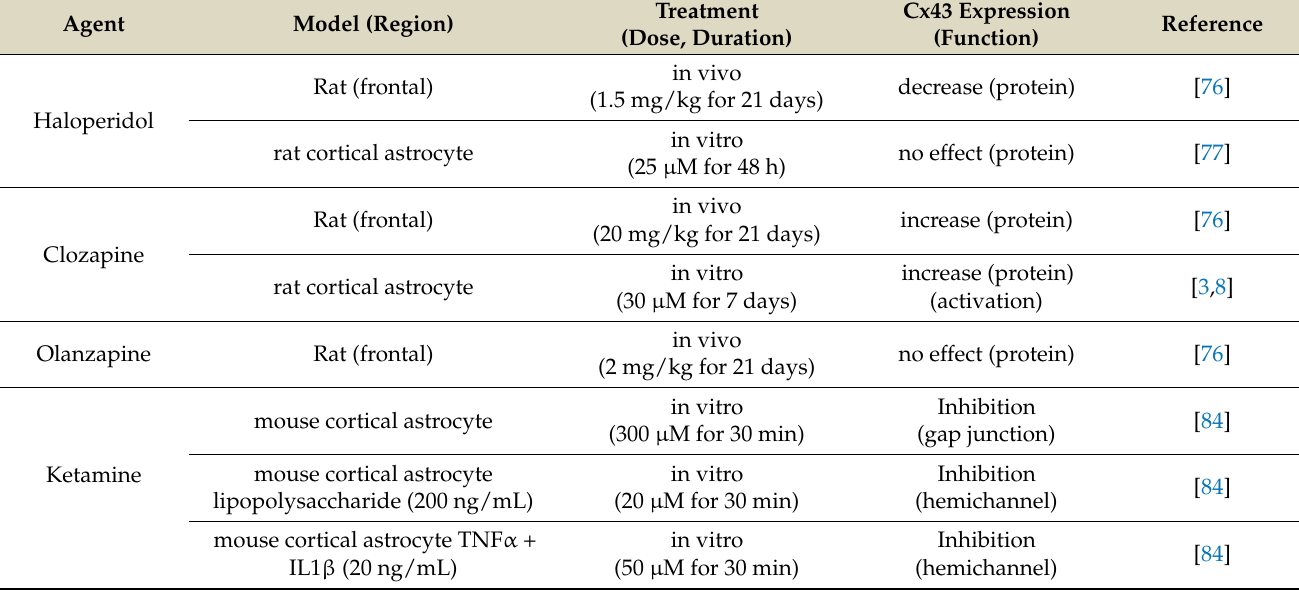
The keywords for search the effects of antipsychotics on Cx43 using MEDLINE were “(((connexin) OR (hemichannel) OR (gap junction)) AND ((psychotropic drugs) OR (antipsychotics)))” for antipsychotics papers published by 1 November 2020. The key words for search the effects of ketamine on Cx43 using MEDLINE were “(((connexin) OR (hemichannel) OR (gap junction)) AND (ketamine))” for papers by 1 November 2020. Relevant articles were obtained in full and assessed for inclusion independently by reviewers. Disagreements among reviewers were resolved via discussion to reach a